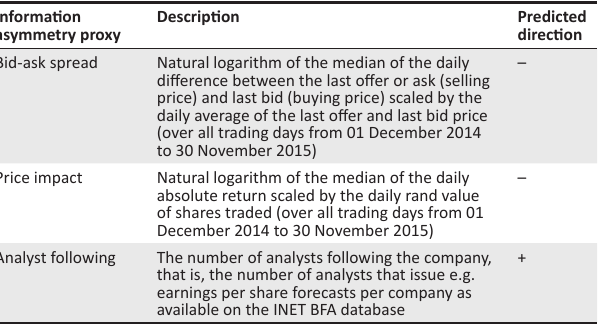
TABLE 1: Information asymmetry proxies – Description and expected IIR